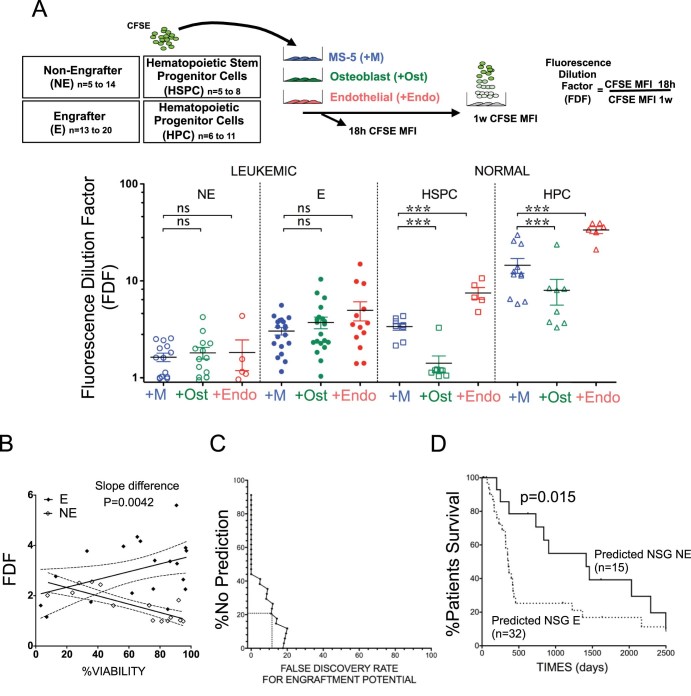
Ex vivo AML sample proliferation measure used to predict patient derived xenograft failure. (A) NE samples have a lower FDF compared with E samples independently of the co-culture system used. In contrast, normal HSPCs or HPCs are influenced by external cues affecting their proliferation profile. The upper flow chart illustrates the experimental design. Five to 14 different NE, 13 to 20 E, 5 to 8 HSPC, and 6 to 11 HPC samples stained with carboxyfluorescein succinimidyl ester were either co-cultured for 1 week with mesenchymal MS-5 cells (+M) or osteoblastic SaOS-2 cells (+Ost) or endothelial HUVECs (+Endo). For each sample and condition, FDF was determined as the ratio of MFI 18 h after staining to MFI measured after 1 week of co-culture. (B) FDF and viability regression analysis for E and NE samples co-cultured for 1 week on MS-5. The 95% confidence band is displayed (dashed curve). (C) A training data set was generated from (B) to derive a computational model for predicting E and NE status for an unknown sample. The data indicate the observed false discovery rate of predictions against the percentage of samples for which the model makes no prediction. (D) Patient survival dichotomized by predicted NSG engraftment potential. A two-sided Wilcoxon test was applied. AML = acute myeloid leukemia; E = engrafter; FDF = fluorescence dilution factor; HUVECs = human umbilical vein endothelial cells; L-LTC-IC = leukemic long-term culture-initiating cells; NE = nonengrafter.